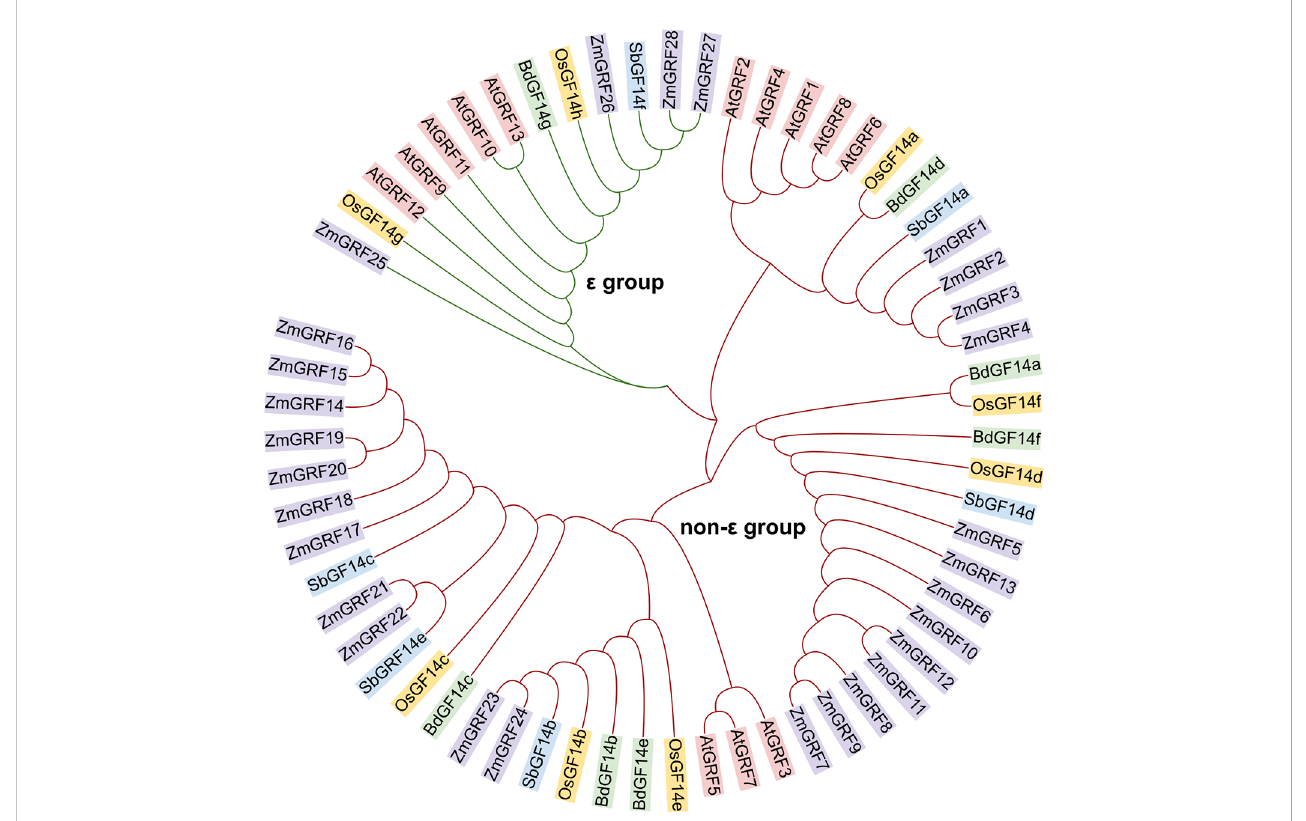
FIGURE 1 Phylogenetic relationship among 14-3-3 proteins in plants. The 14-3-3 protein sequences of Arabidopsis thaliana, maize, rice, sorghum and Brachypodium were mapped using Multiple Sequence Alignment by CLUSTALW . The 14-3-3 proteins in the phylogenetic tree were divided into two groups ( ϵ group and non- ϵ classes). At, Arabidopsis thaliana ; Zm, Zea mays ; Os, Oryza sativa ; Sb, Sorghum bicolor ; Bd, Brachypodium distachyon